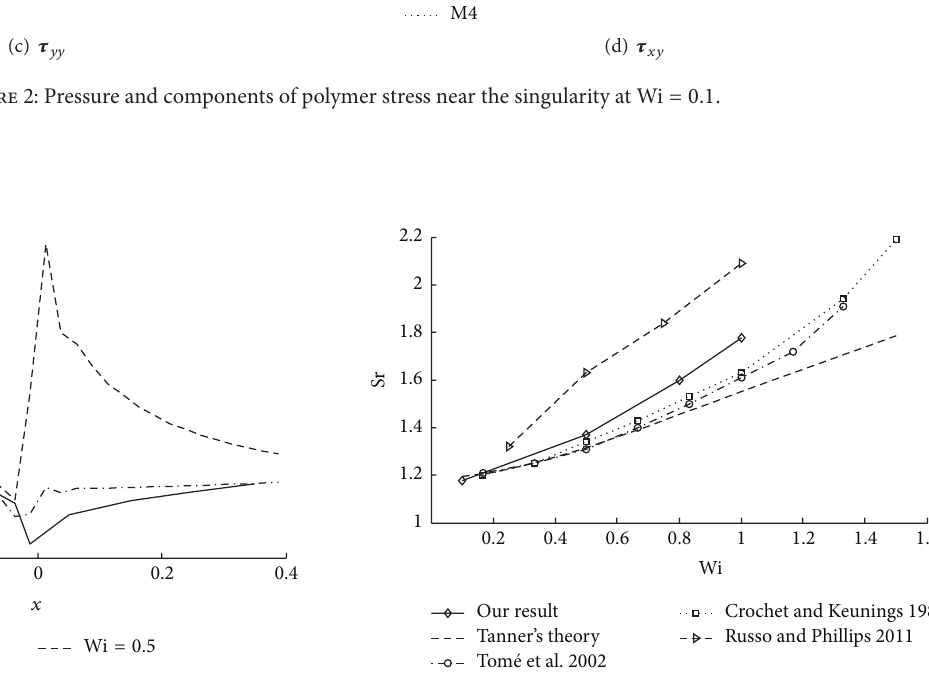
Figure 3: 𝜏 𝑦𝑦 near the singularity for various Wi. Figure 4: Swelling ratio with the increase of